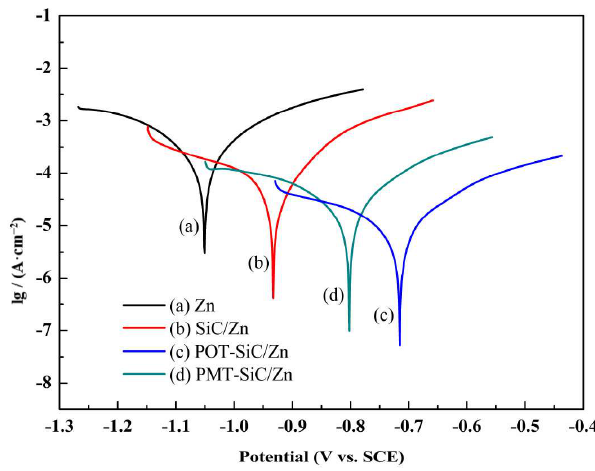
Figure 8. Tafel plots of electrodeposited and bilayer coatings after immersed in 3.5% NaCl solution 168 h. Table 1. Fitting corrosion parameters for electrodeposited and bilayer coatings after immersed in 3.5% NaCl solution for 168 h by Tafel polarization and electrochemical impedance spectroscopy (EIS)